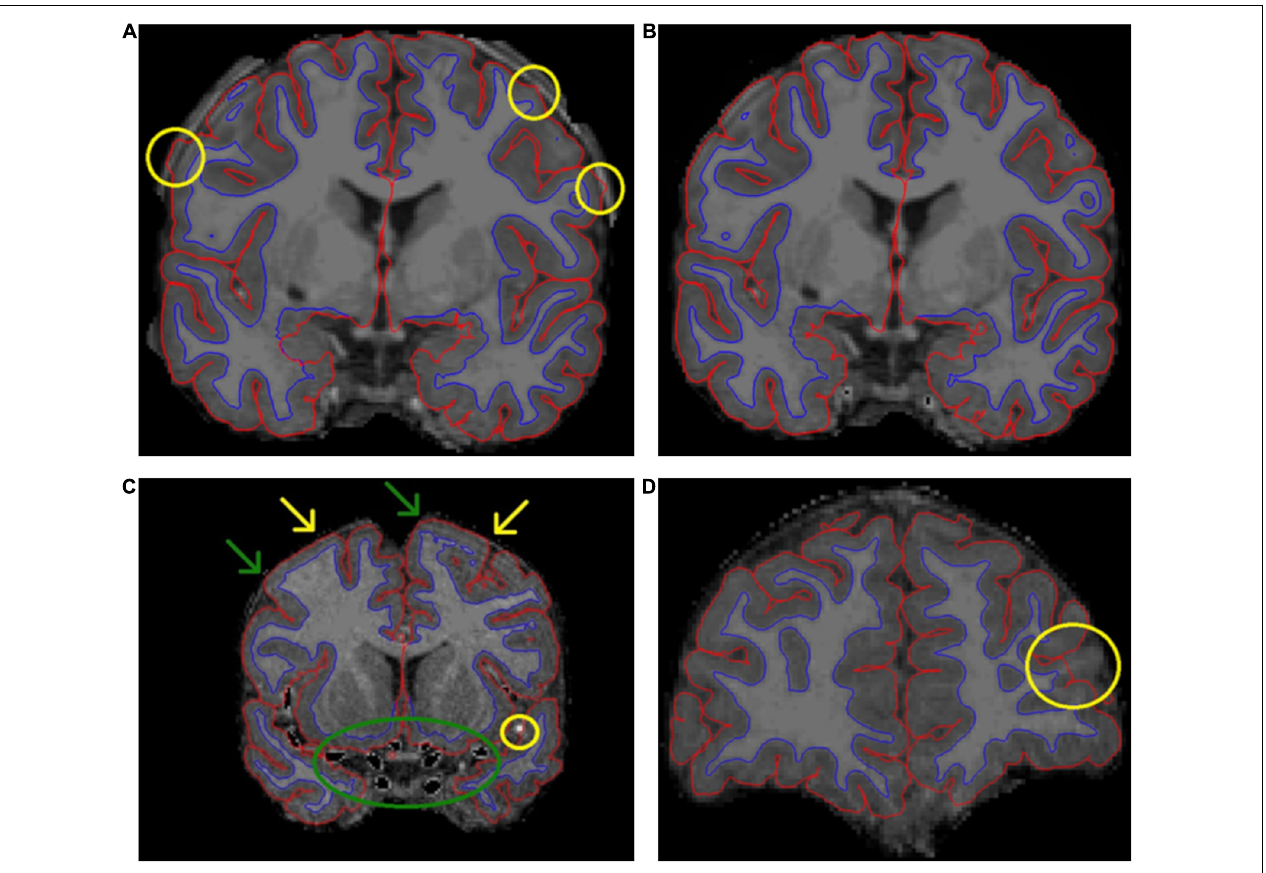
FIGURE 2 | A presentation of some common errors and fixes related to the pial border and non-brain tissues. (A) Demonstrates how skull fragments can cause errors in pial border (yellow circles). (B) Presents the same subject with skull fragments removed. In panel (C) , arteries were removed (green circle). We removed voxels with an intensity between 130 and 190, and therefore some parts of arteries were not removed (yellow circle). (C) Also demonstrates the challenges with artifact, meninges, and the pial border. In some areas, the pial border may extend into the meninges (yellow arrows). Meanwhile, at the other end of the same gyrus, the border may seem correct (green arrows). It is difficult to fix these errors manually. Additionally, the visible motion artifact adds further challenges to manual edits of the pial border. In panel (D) , the pial border cuts through a